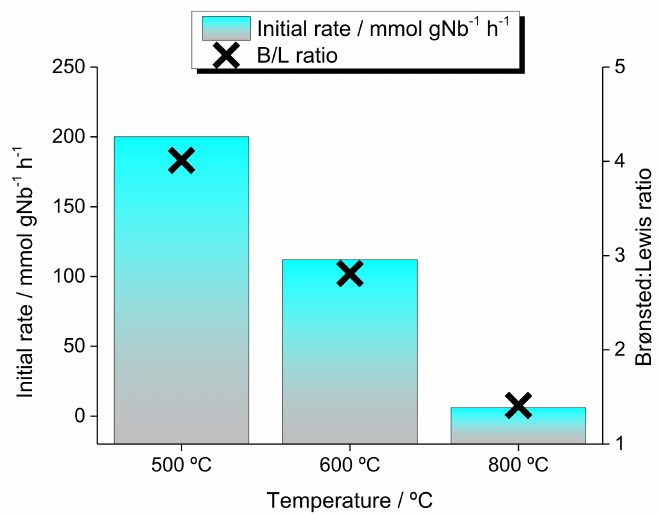
Figure 33. Effect of the B/L ratio and calcination temperature of catalyst in esterification of propanoic acid with methanol over Niobium supported on SBA-15 (2 wt% Nb/SBA-15). Reaction conditions: Methanol: propanoic acid molar ratio (30), catalyst (50 mg), temperature (60 ◦ C), dihexylether as internal standard (0.12 mL) (adapted from